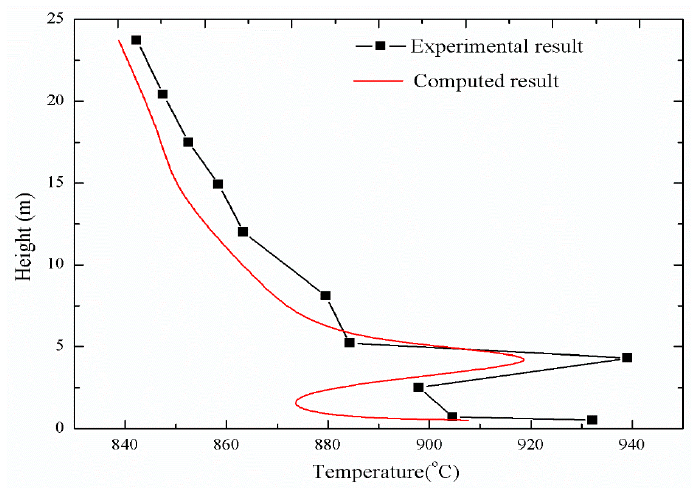
Figure 11. Comparison of temperature distribution under stable operating conditions.